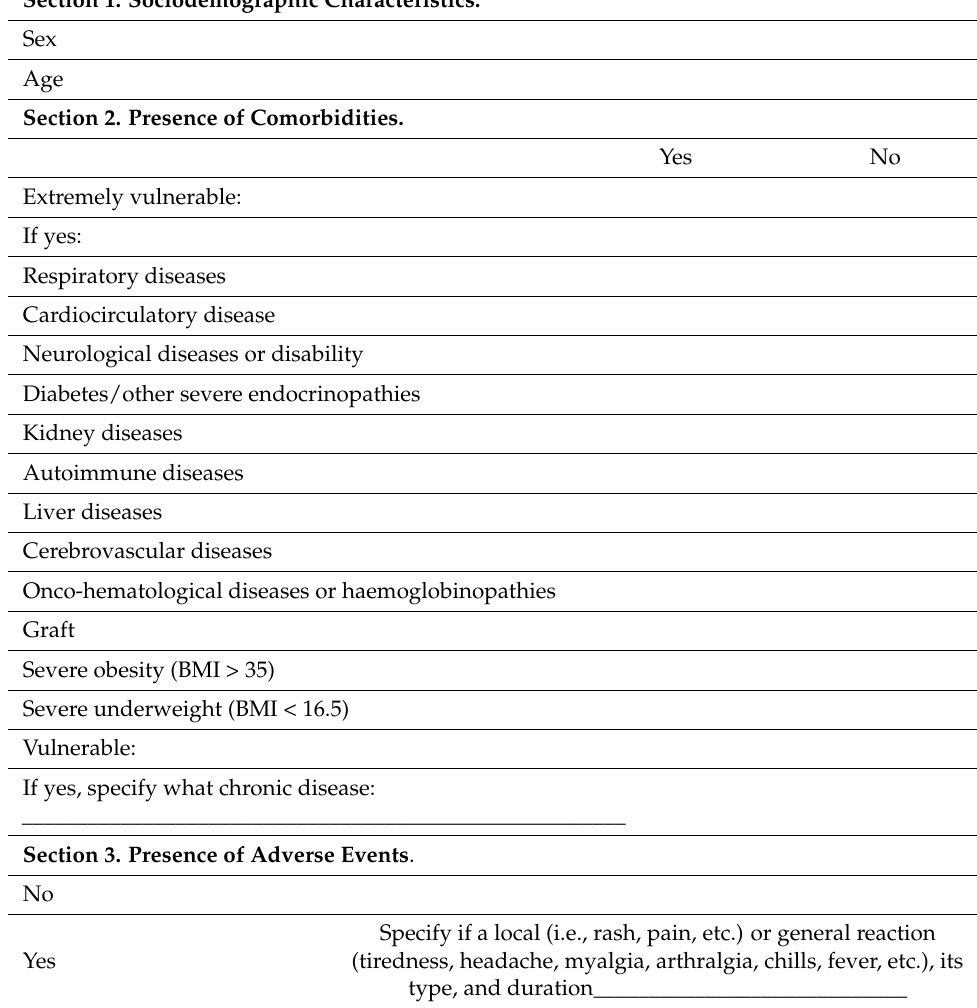
Table 1. Questionnaire. Section 1. Sociodemographic